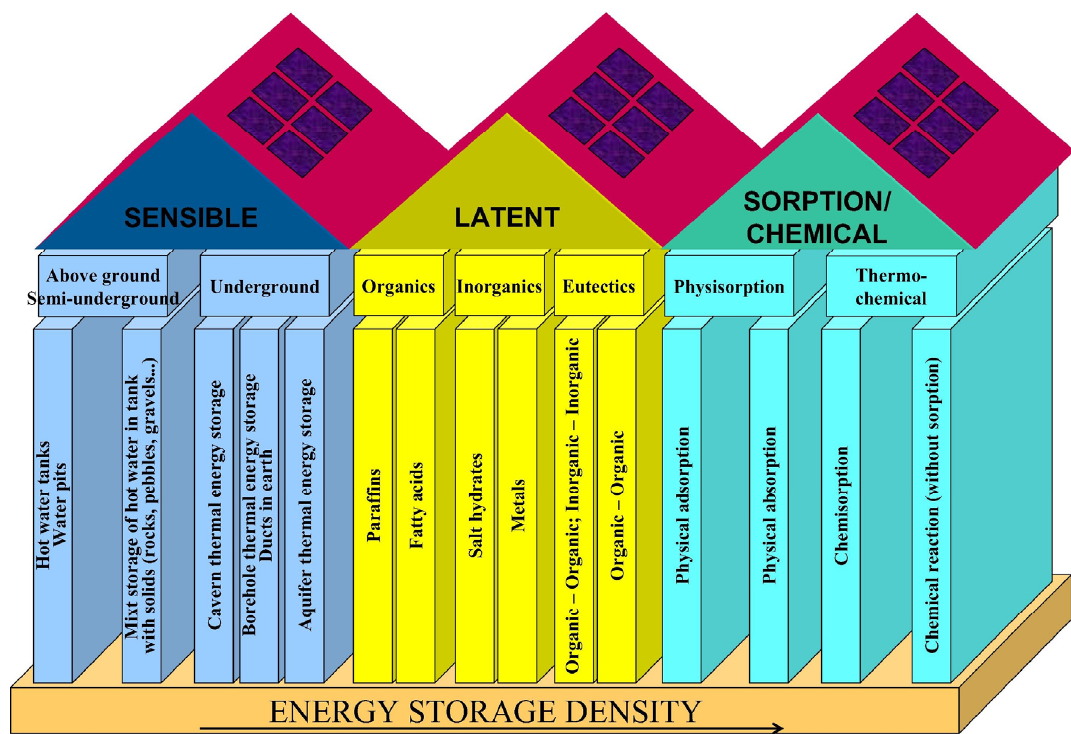
Figure 1. TES classification (reprinted from [3], with permission from Elsevier).